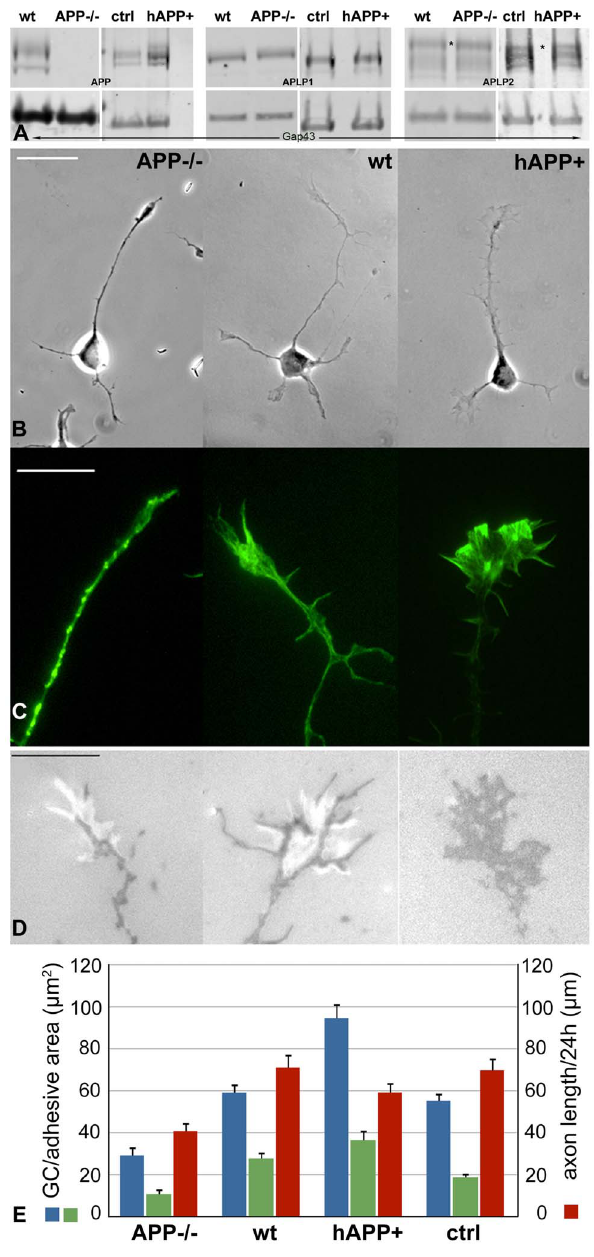
Figure 3. GC size, adhesion and advance of APP mutant neurons on laminin. A. Western blots of GCPs isolated from newborn brain of wt and mutant mice. Blots were probed for APP (M r , 100 kDa), APLP1 (M r =72 kDa), and APLP2 (M r =87 kDa, asterisk) and for Gap43 as loading control. APLP1 and APLP2 levels were the same in wt and mutant mice. B. Phase contrast images of wt and mutant neurons and ( C ) TIRF images of their GCs labeled with fluorescent phalloidin. D. RICM images of live GCs showing close adhesions (dark) and wide contacts (bright). hAPP + control GCs (ctrl; non-transgenic siblings) were the same as wt and, therefore, are not shown. Scale bars, 20 m m ( B ) and 10 m m ( C, D ). E. GC area (blue), cumulative adhesive area (green) and axon length (red) at 24 h in vitro for the indicated mouse strains (means 6 s.e.). For statistical analysis, see Tables 1 and 2.